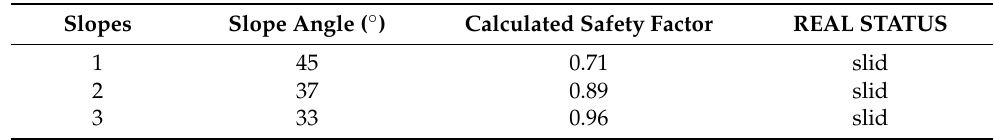
Table 3. The safety factor of three slopes